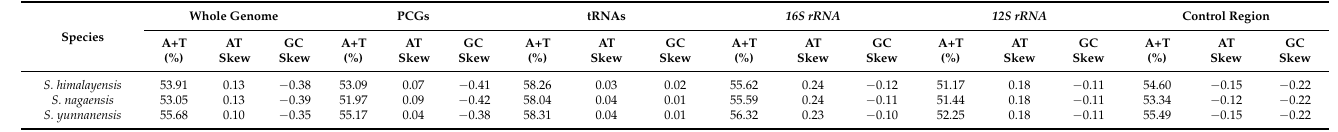
Table 3. Nucleotide composition of the mitochondrial genome of the three Sitta species in this